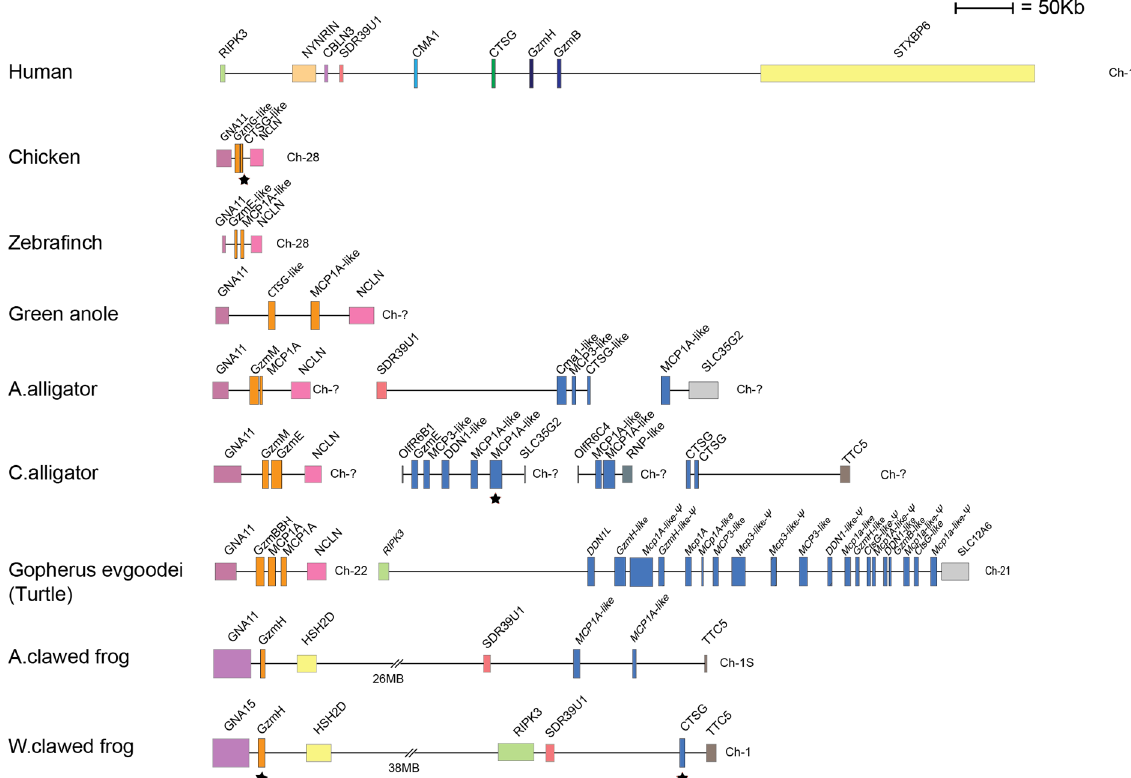
Figure 2. The chymase locus and a related locus of a panel of non-mammalian tetrapod species. An in scale figure of a panel of non-mammalian tetrapods ranging from amphibians to birds. The genes are color coded. In the human locus the granzymes are shown in dark blue, α -chymases in light blue, β -chymases as blue with a darker tint and cathepsin G in green. In the amphibians and reptiles the genes cannot be assigned to any of the major groups of mammalian enzymes and are therefore shown in a light-dark blue color. The genes for which we have produced recombinant proteins are marked by black stars. The protease genes within the additional locus present in birds, reptiles and amphibians but has been lost in mammals are shown in